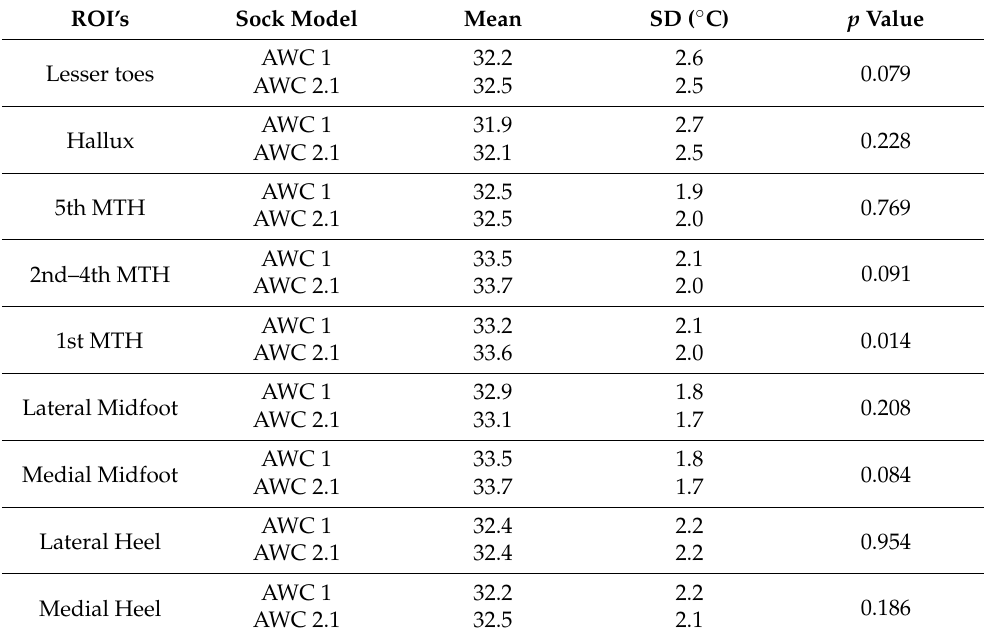
Table 4. Comparison of post-exercise temperature between the AWC 1 and AWC 2.1 sock